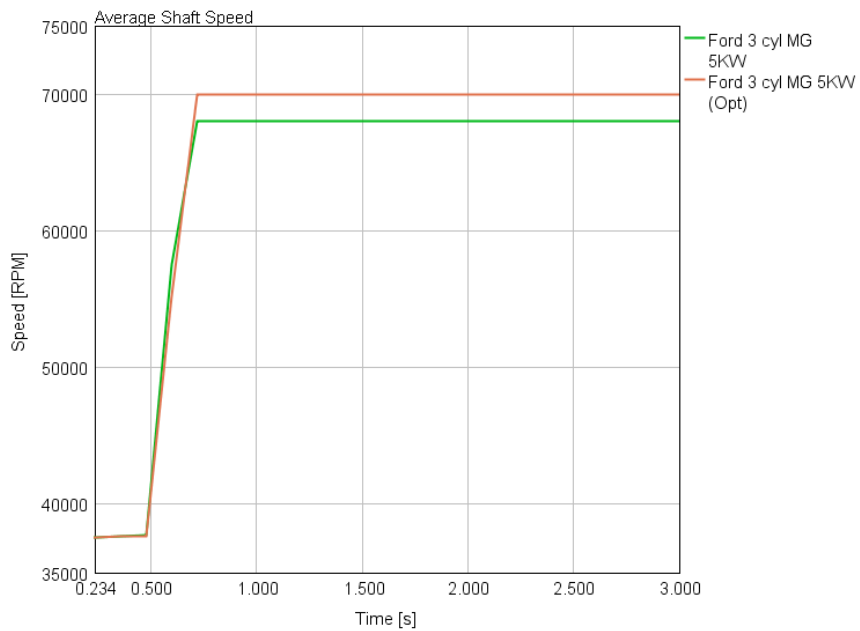
Figure 30. Average shaft speed of the electrically assisted turbocharger (EAT) models with 5 kW power level at 1000 rpm engine speed.